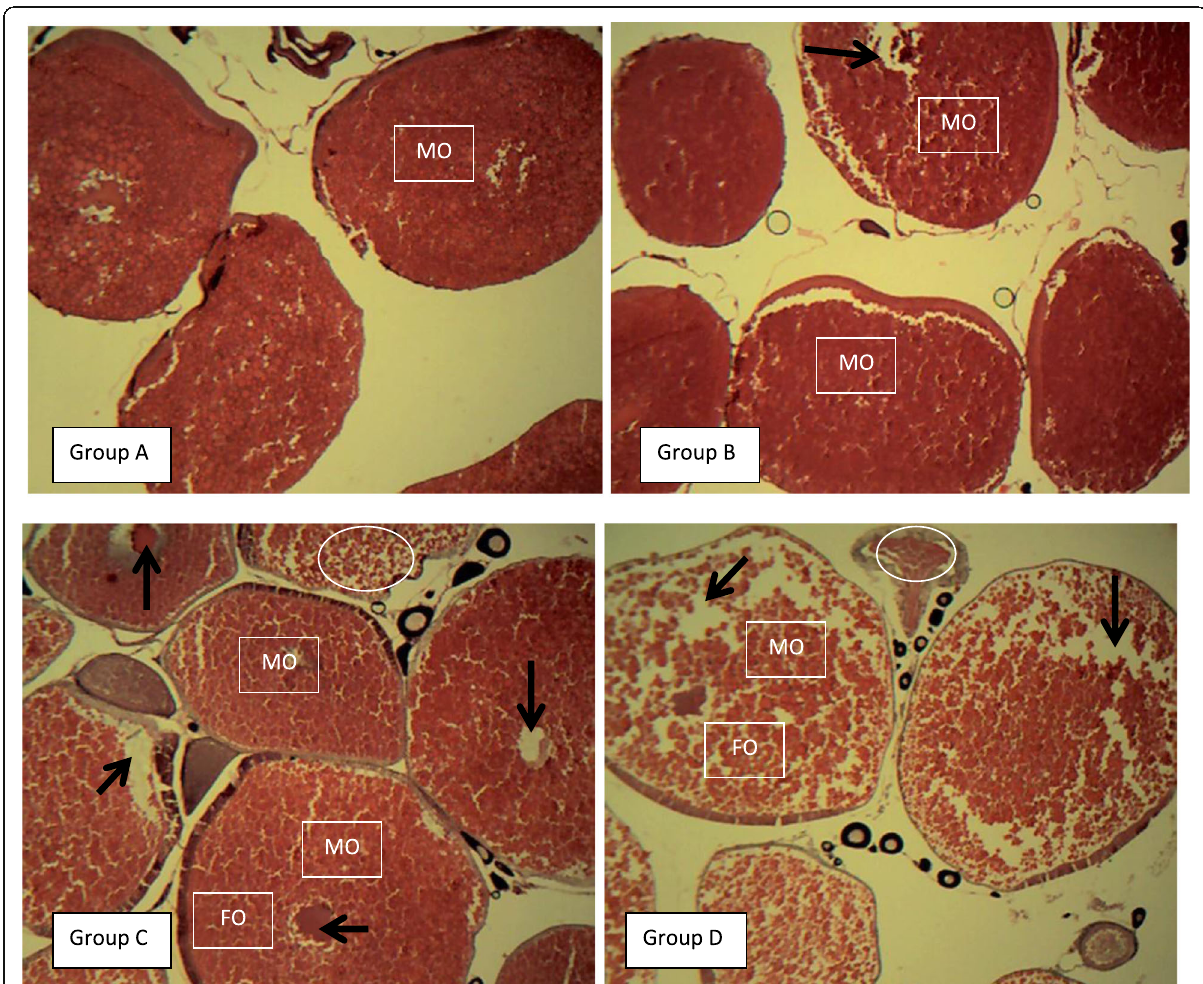
Fig. 5 Histopathology of the ovary of C. gariepinus exposed to different concentration of lambda-cyhalothrin after day 1. Group A (control), B (2.5 × 10 − 4 μ g/L), C (5.0 × 10 − 4 μ g/L), and D (8.25 × 10 − 4 μ g/L) (MO, mature oocyte; FO, flabby oocyte; white circle, degenerative ovarian changes; black arrow, vacuolation; H&E; Mag. ×